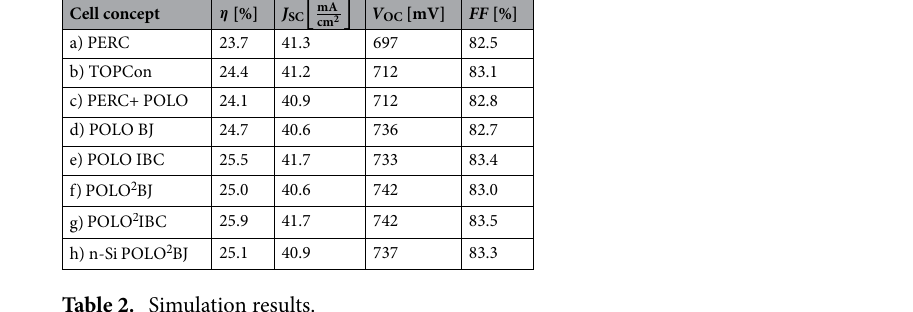
Table 2. Simulation